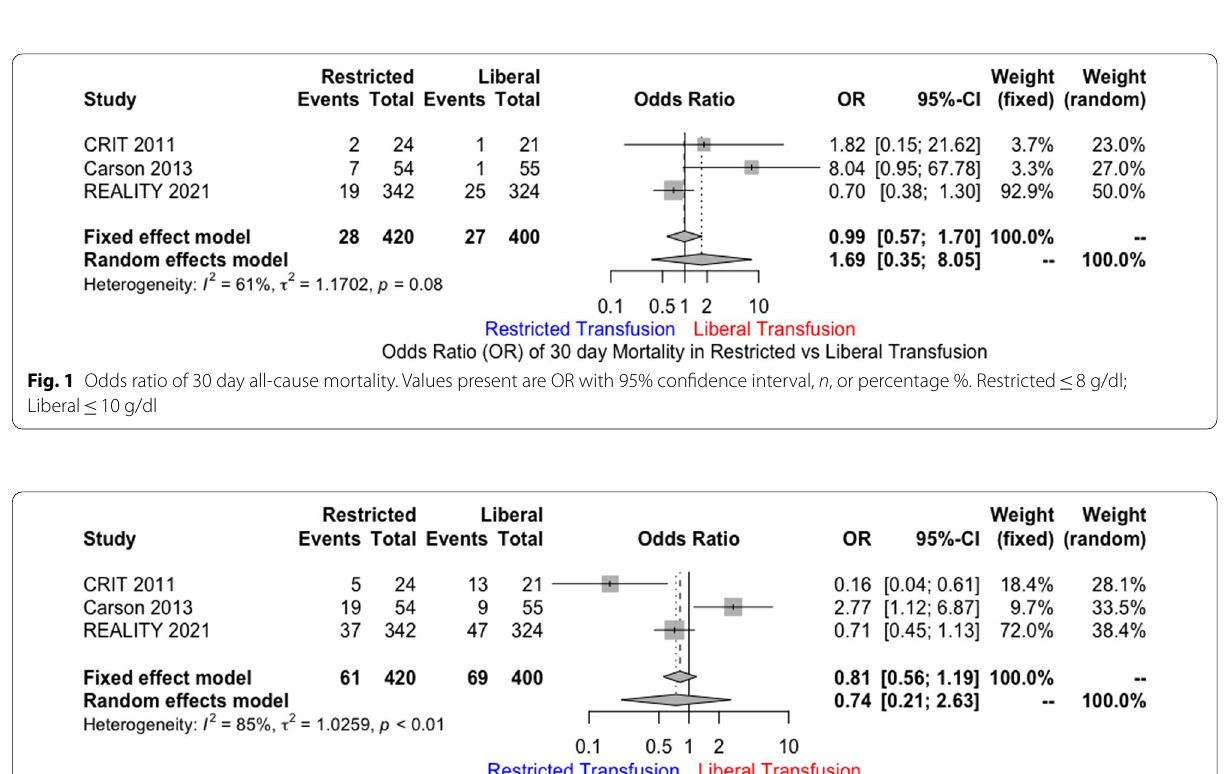
HTN hypertension, DM diabetes mellitus, MI myocardial infarction, PCI percutaneous coronary intervention, R restrictive transfusion, L liberal transfusion